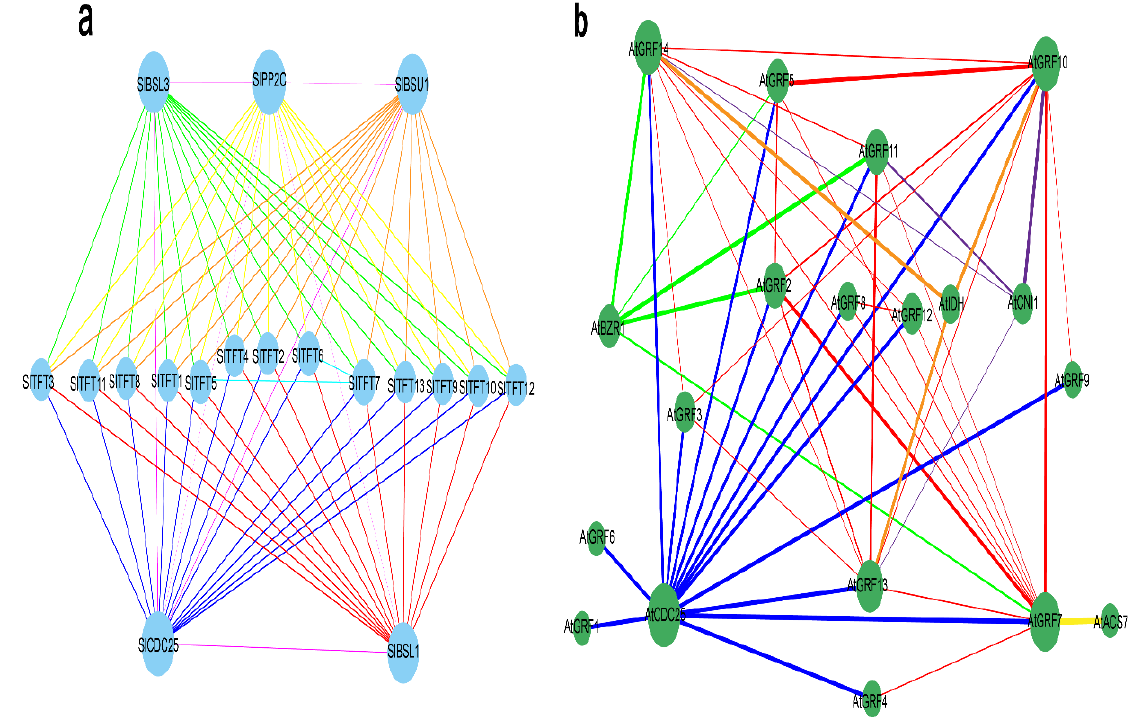
Figure 10. Protein interaction network diagram. ( a ) Protein interaction network between SlTFTs and other proteins in tomato. ( b ) Protein interaction network between AtGRFs and other proteins in A. thaliana . Lines of different colors and thicknesses represent the interactions between different proteins. Network construction was performed using String 11.5. In the basic settings, select the full STRING network (the edges indicate both functional and physical protein associations) as the network type. The line color indicates the type of interaction evidence chosen to indicate the meaning of network edges. Active interaction sources include text mining, experiments, databases, co-expression, neighborhood, gene fusion, and co-occurrence. The minimum required interaction score is medium confidence (0.40). The network display mode in the advanced settings is set to interactive SVG (network is a scalable vector graphic [SVG]; interactive). In the network display option, click the “hide disconnected nodes in the network” button.